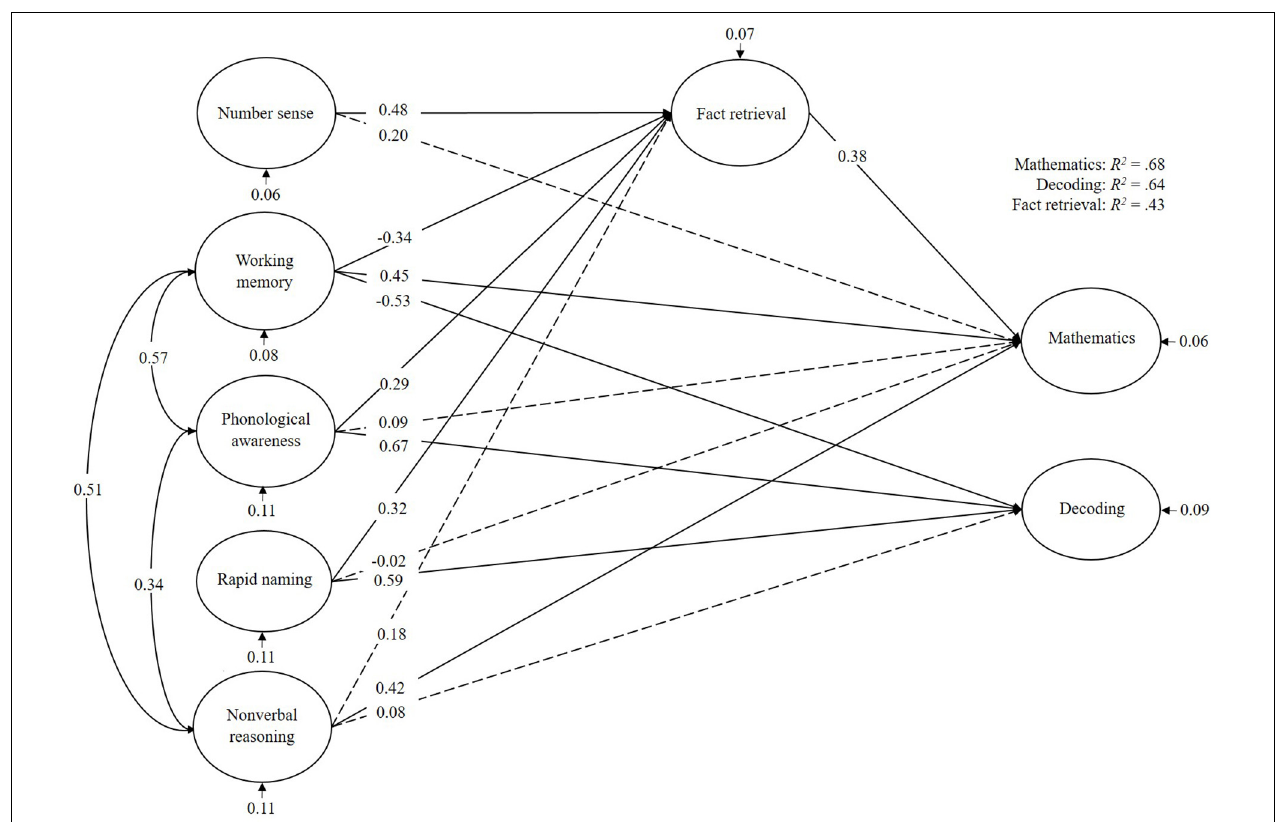
FIGURE 2 | Bayesian structural equation model for typical developing children. Denoted values are beta